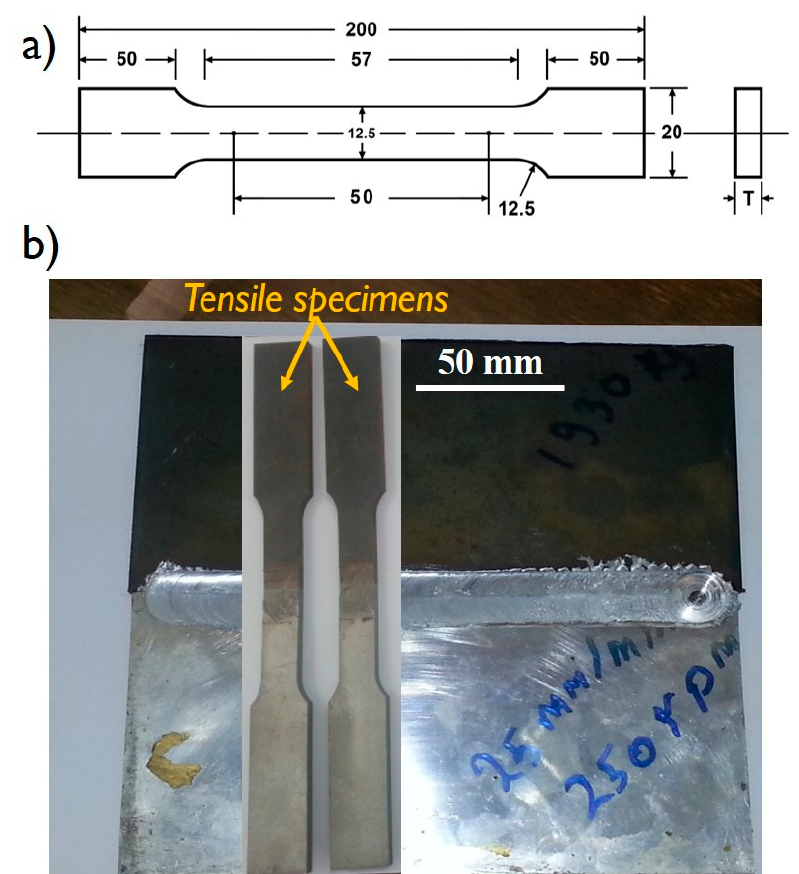
Figure 2. ( a ) Schematic representation and dimensions of the tensile test specimens according to ASTM E8M-04 standard and ( b ) a top image for one of the aluminum–steel friction stir welded (FSWed) joints with the tensile specimens superim- posed. Note: All dimensions in ( a ) are in